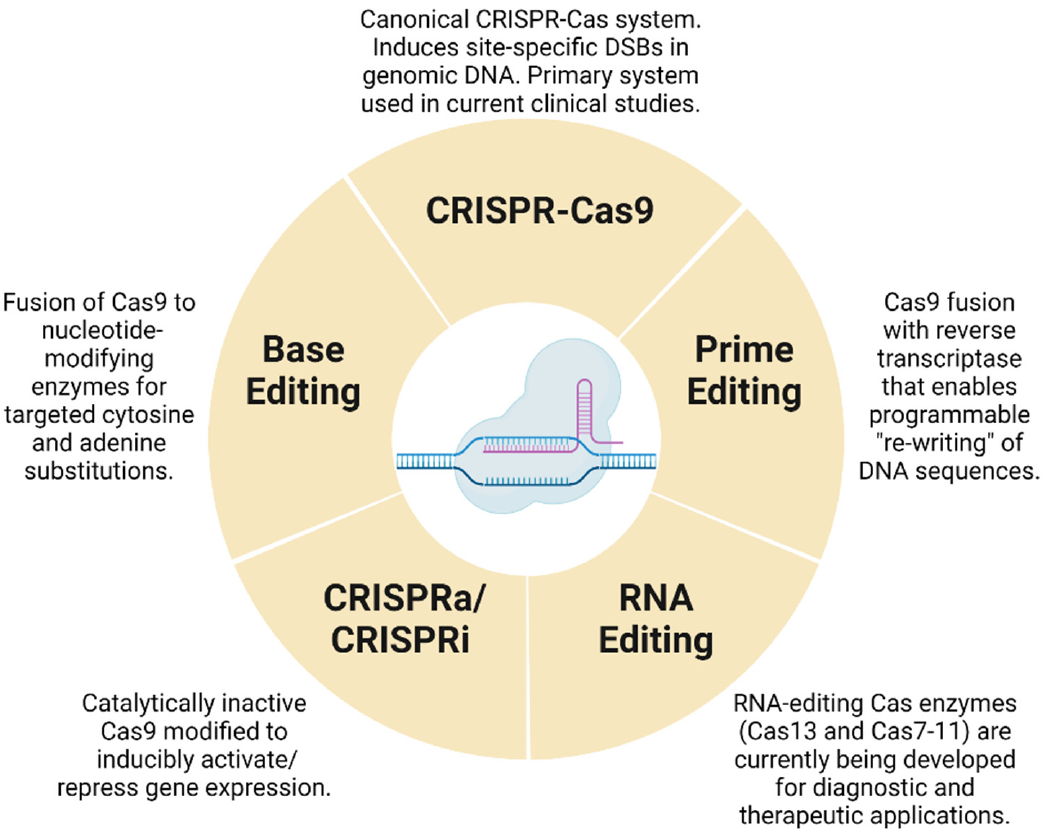
Figure 1. Summary of the various CRISPR-Cas systems discussed in this review.